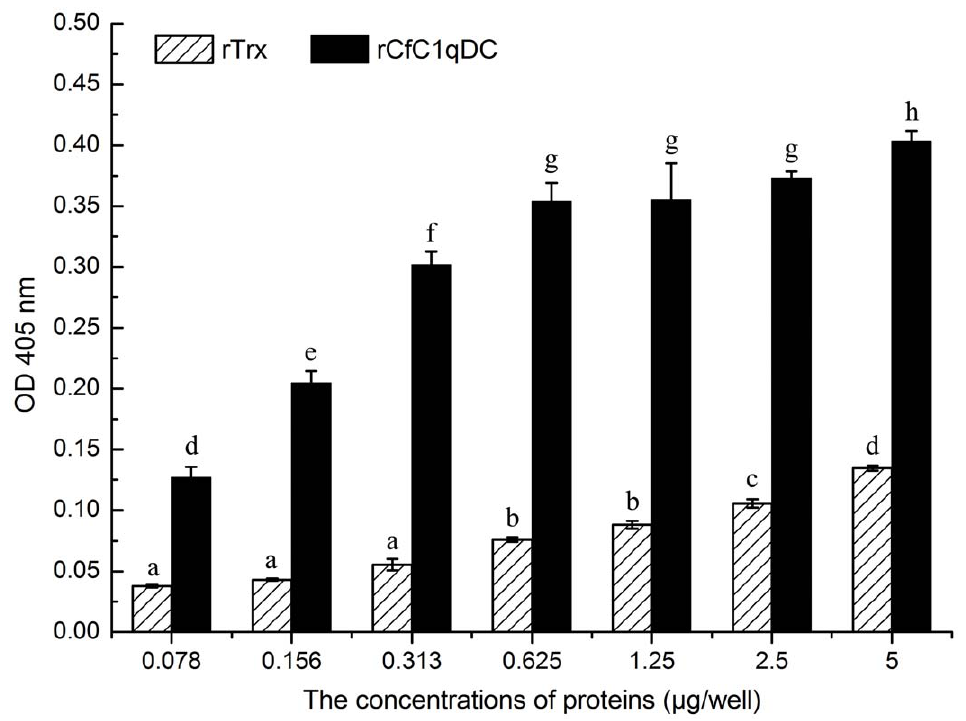
Figure 6. ELISA analysis of the interaction between rCfC1qDC and human heat-aggregated IgG. Plates were coated with various PAMPs several concentrations of rCfC1qDC and rTrx, and then incubated with human heat-aggregated IgG. The interaction was detected with goat–anti-